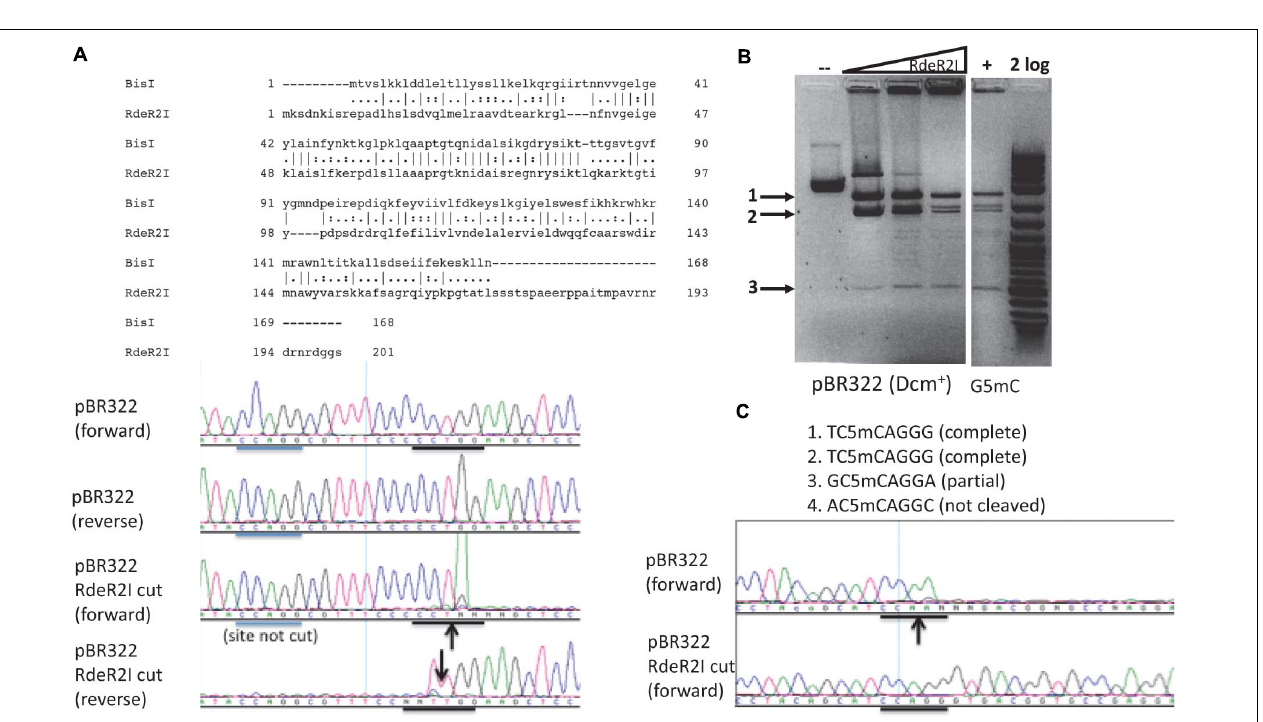
FIGURE 5 | VarFI digestion of pBR322 DNA and mapping of nicking sites in pBR322. (A) VarFI digestion of pBR322 (lane 1); lane 2, uncut pBR322. SC, supercoiled DNA; L, linear DNA; NC, nicked circular DNA. (B) Consensus sequence (RY ↓ NRY) of VarFI nicking sites in pBR322. Down arrow indicates the nicked position. (C) Mapping of VarFI nicking/cleavage sites by DNA run-off sequencing. The up arrows indicate the nicking/cleavage position of the template strand, where Taq DNA polymerase added an extra A (e.g., A/G or A/C doublet) when the template is broken. Top sequence, pBRFM (uncut); middle sequence, VarFI digested DNA in B3.1; bottom sequence, VarFI digested DNA in B2.1.